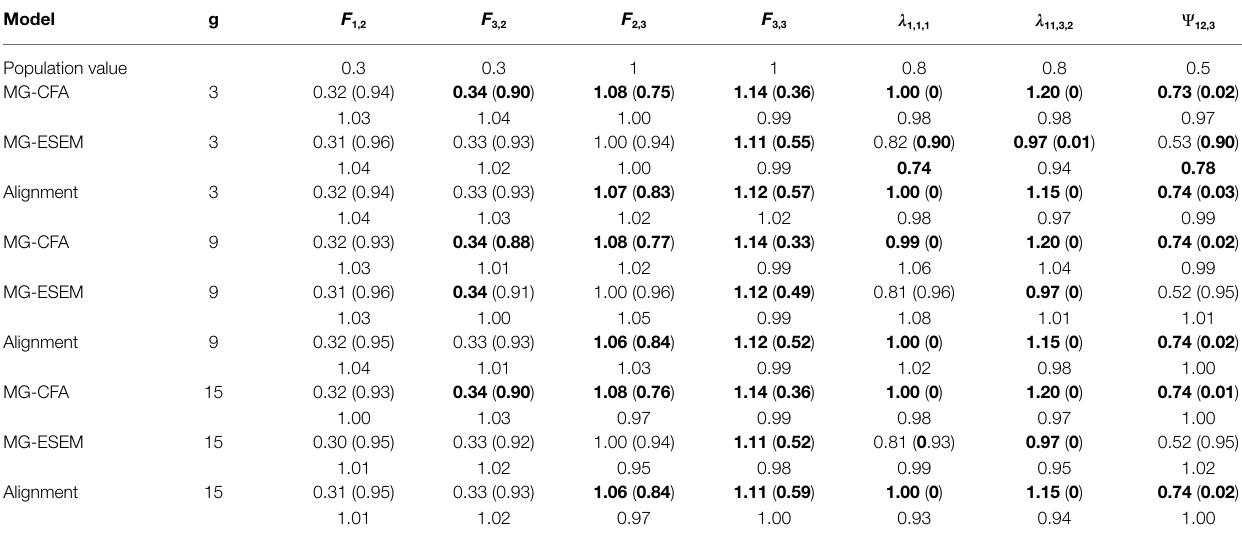
The values inside parentheses are coverage rates, the values on the left side of the parentheses are parameter estimates, the values under the parameter estimates and coverage rates are ratios of average standard error to standard deviation. The values in bold do not meet the four standards which determine the accuracy of parameter estimates proposed in research design section.